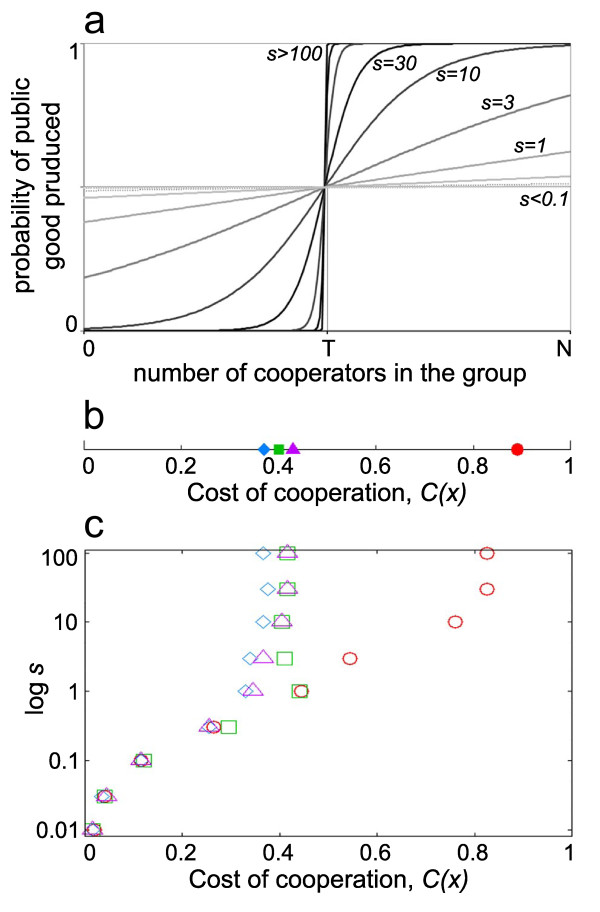
The effect of s parameter on the level of cooperativeness in the population. (a) The s parameter determines the steepness, hence the shape of the sigmoid function. When s approaches ∞, the probabilistic benefit function approaches to strict deterministic step-wise function, meaning that above the threshold (T) the public good is always achieved, while below never. With decreasing s the probability of public good achievement changes from strict all or nothing to a smoother function. In the later case there is a non-zero probability of achieving the common goal even below the threshold, and also above the threshold the group can fail. (b) The position of the hysteresis point with the use of strict deterministic step-wise benefit function. (c) The effect of s (steepness of the sigmoid function) parameter on the location of the hysteresis point. The hysteresis point indicates the highest cost value for which cooperation is still a stable outcome of the game, and even a small increase in the cost would cause the collapse of this polymorphic equilibrium to defection. Below this cost value we always find cooperative equilibria. (●,○: T = 5; ■,□: T = 4; ♦,◊: T = 3; ▲, Δ: T = 2).